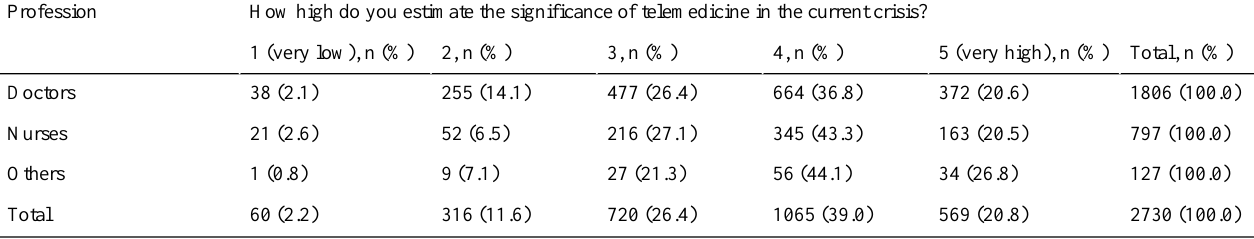
Table 2. Significance of telemedicine in the coronavirus crisis. How high do you estimate the significance of telemedicine in the current